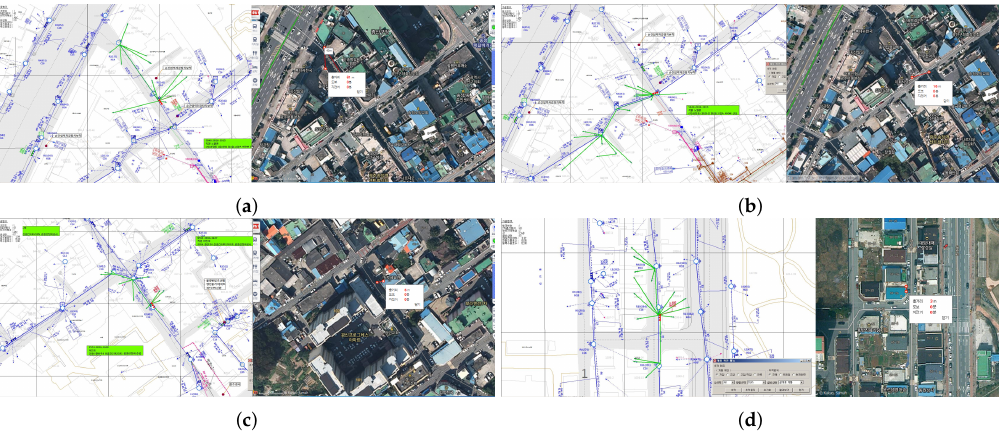
Figure 15. NDIS maps for the Overhead Commercial Area. ( a ) Site 2-1. ( b ) Site 2-2. ( c ) Site 2-3. ( d ) Site